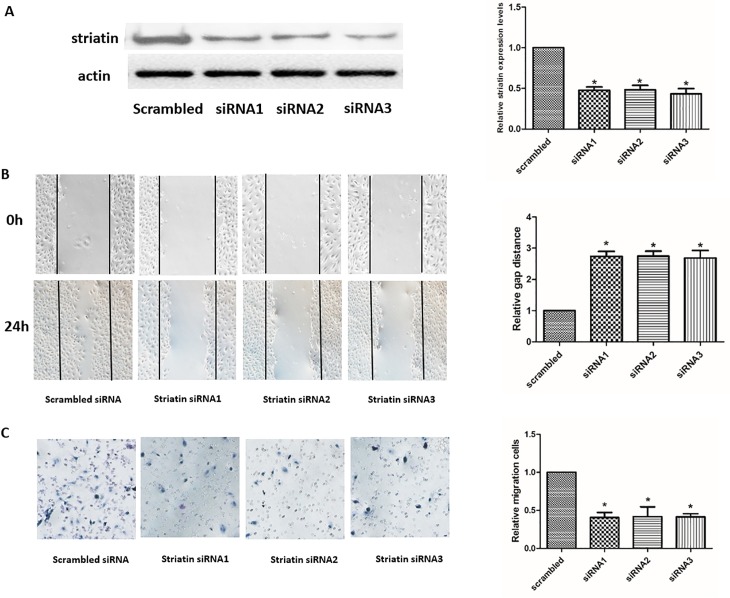
Silencing striatin in HUVECs inhibites cell migration.(A) HUVECs were transfected with scrambled siRNA or striatin targeted siRNA 1, 2 or 3 for 48h. Striatin densitometry values were adjusted to actin intensity, then normalized to expression from the control sample. Expression in CON group was normalized to 1, *p<0.01 versus CON. Bars represent SD, n = 4. (B) After transfection assays, HUVECs were scrapped to create a cell-free (wounded) area. Cells were incubated with 10nM E2 or with solvent as control for another 24h. Migration was monitored. Representative images of cell migration are shown. Gap distance in CON group was normalized to 1, *p<0.01 versus CON. Bars represent SD, n = 6. (C) After transfected with striatin siRNA1, 2, 3 or scrambled siRNA for 24h, transwell experiments were performed. Representative images of transwell experiments are shown. The number of the invaded cell in the lower surface of the membrane in CON group was normalized to 1, *p<0.01 versus CON. Bars represent SD, n = 6.